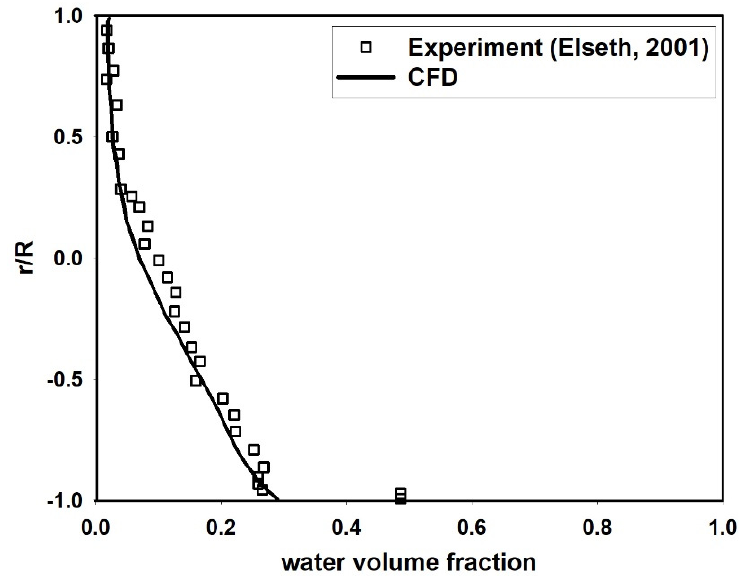
Figure 10. Vertical profile of in situ water volume fraction as measured in the experiment and predicted by CFD model for test 3 (mixture velocity = 2 m/s, water cut = 0.1).